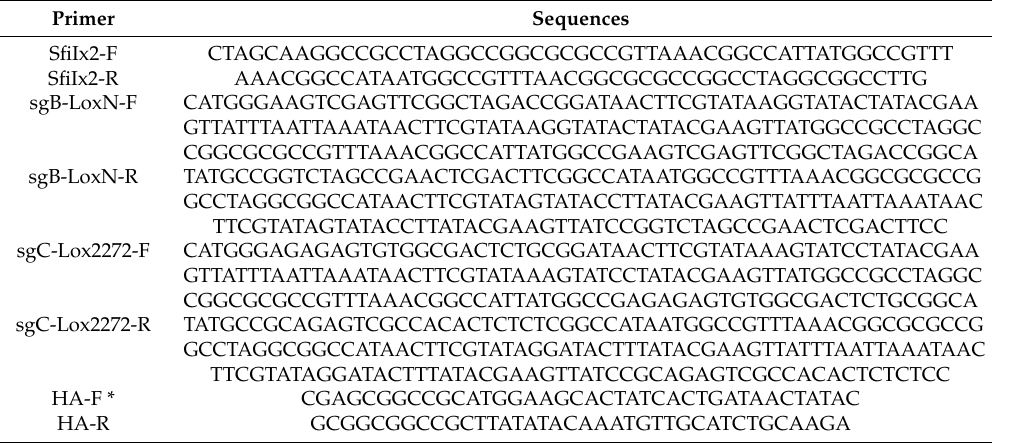
Table 2. Primer sequences used for donor